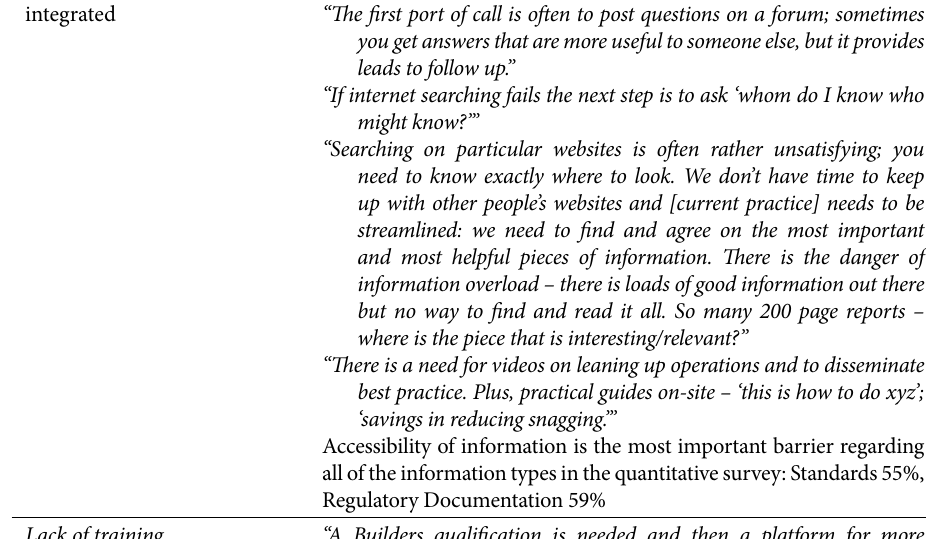
Table 3. organisational perceived barriers to engagement with sustainable construction organisational perceived Triangulated qualitative and quantitative examples barriers Lack of enabling